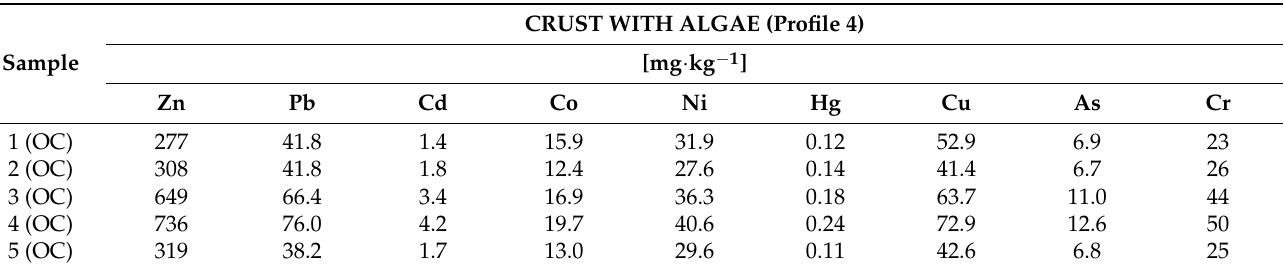
Table 6. Content of heavy metals in the algal crusts. CRUST WITH ALGAE (Profile